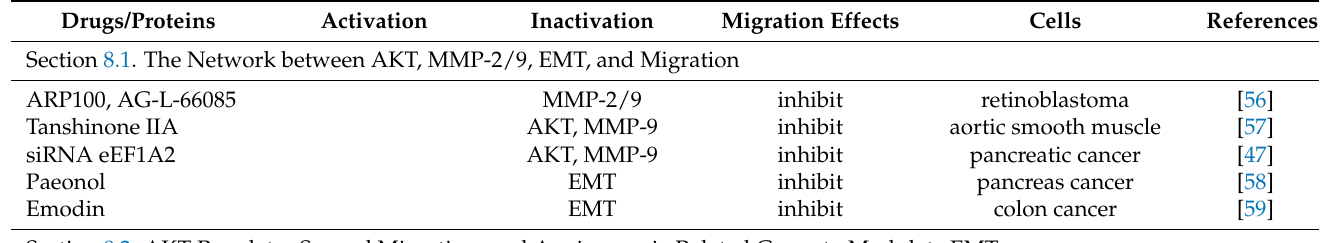
Table 1. Summary for the AKT-regulating–AKT-signaling network and modulating migration and